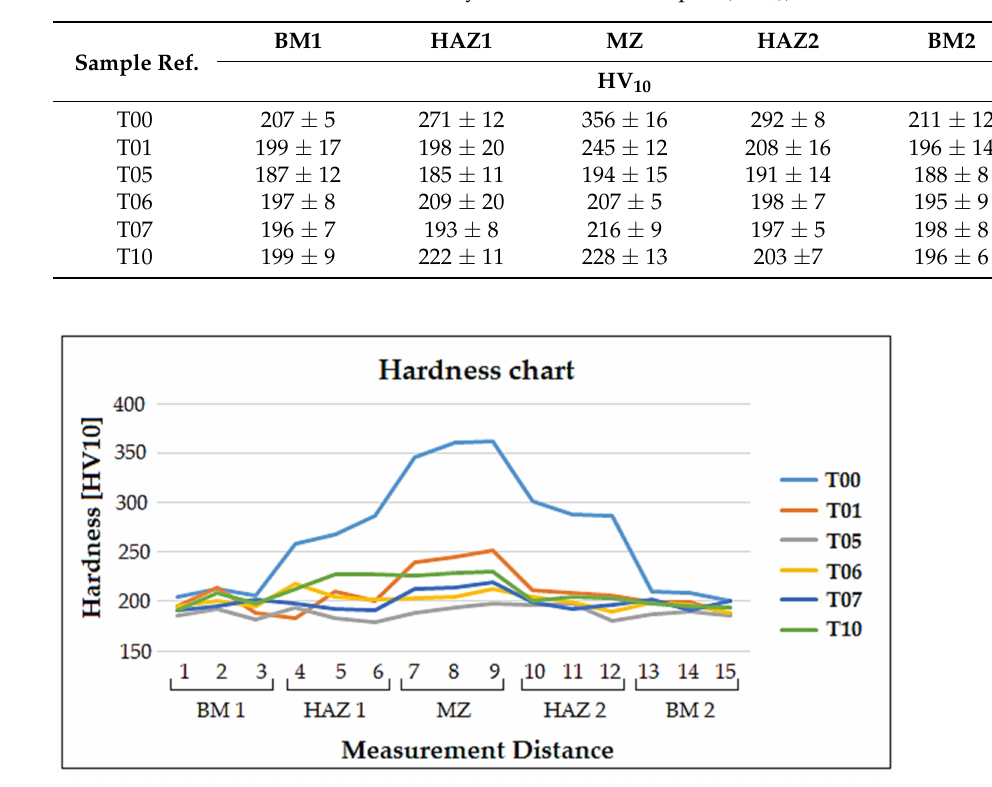
Figure 2. Hardness profile of the differently treated welded samples across all zones of the weld (BM 1, HAZ 1, MZ, HAZ 2 and BM 2 respectively).